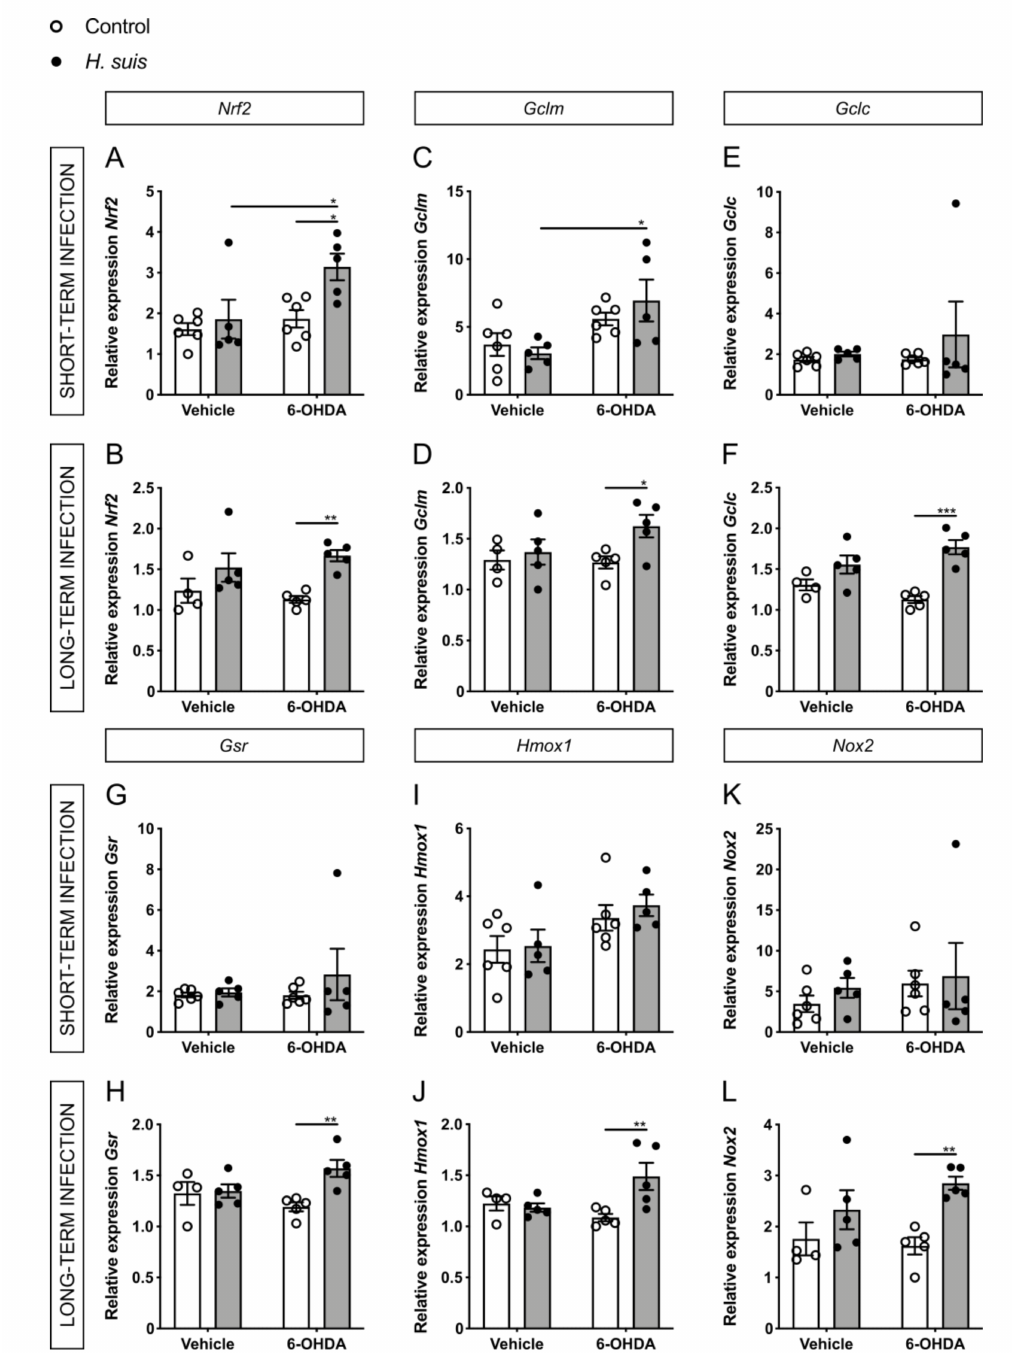
Figure 8. Helicobacter suis ( H. suis ) infection is associated with an increased gene expression of antioxidant nuclear factor (erythroid-derived 2)-like 2 ( Nrf2 )-associated genes. ( A – L ) Relative mRNA gene expression of Nrf2 ( A , B ) and its downstream regulators glutamate-cysteine ligase modifier subunit (Gclm) ( C , D ), glutamate-cysteine ligase catalytic subunit ( Gclc ) ( E , F ), glutathi-one-disulfide reductase ( Gsr ) ( G , H ), heme oxygenase 1 ( Hmox1 ) ( I , J ), and NADPH oxidase 2 ( Nox2 ) ( K , L ) in the forebrain, 7 days after intrastriatal injection with either 6-hydroxydopamine (6-OHDA) (n = 5) or vehicle (n = 4–5), of mice infected with H. suis (black) or the control broth (white) for a short-term period ( A , C , E , G , I , K ) or a long-term period ( B , D , F , H , J , L ). * 0.01 ≤ p < 0.05; ** 0.001 ≤ p < 0.01; *** 0.0001 ≤ p <